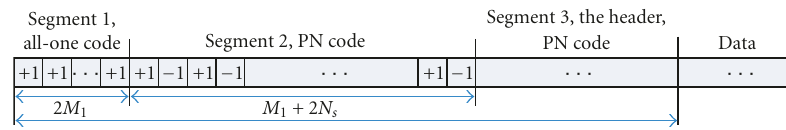
Figure 6: The signal structure for training